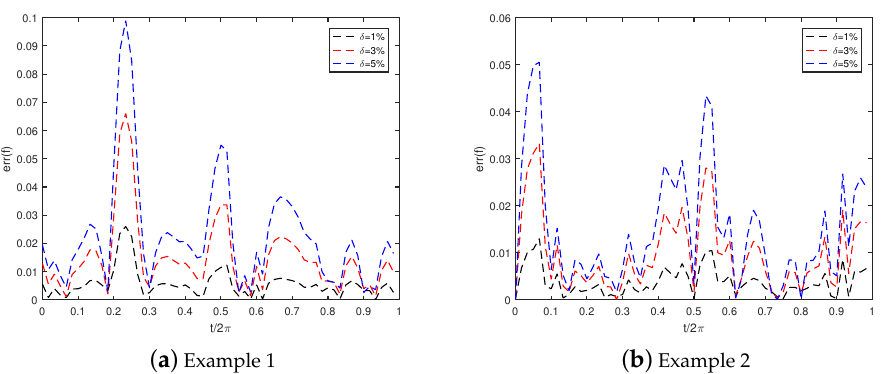
Figure 2. The relative errors of u in each knot with the percentages of noise increasing from 1% to 5% on ∂ D .